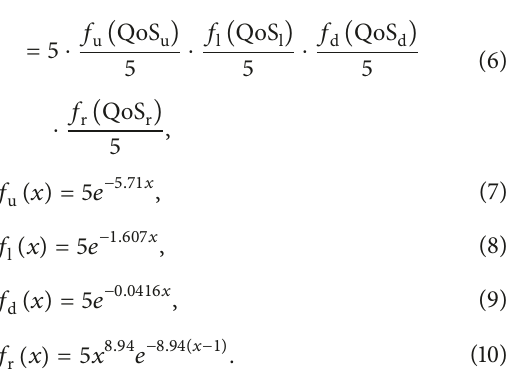
Figure 7: QoE/MOS monitoring